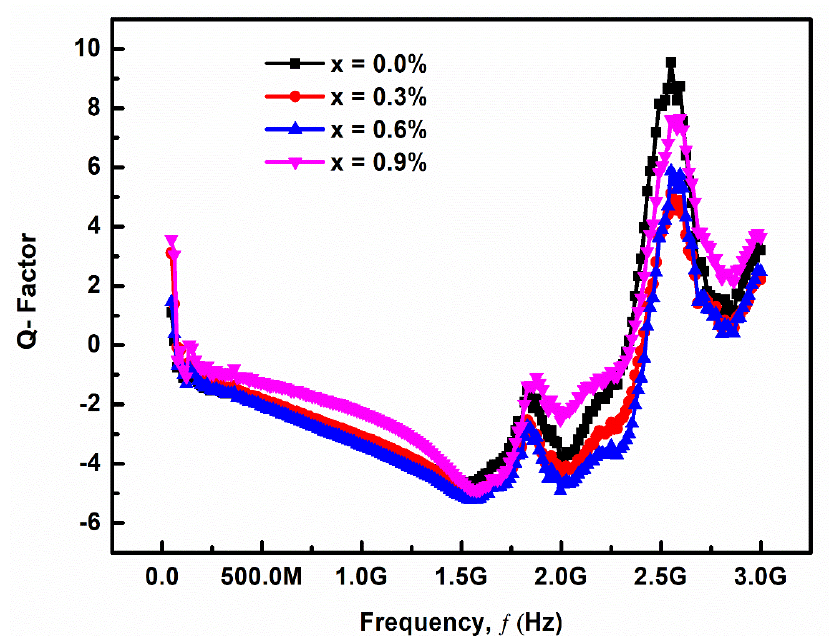
Figure 5. Variation Q factor with frequency for (Ba 1−x Ca x )Ti 4 O 9 (x = 0.0, 0.3, 0.6 and 0.9) sintered ceramics at 1000 °C for 4 h.